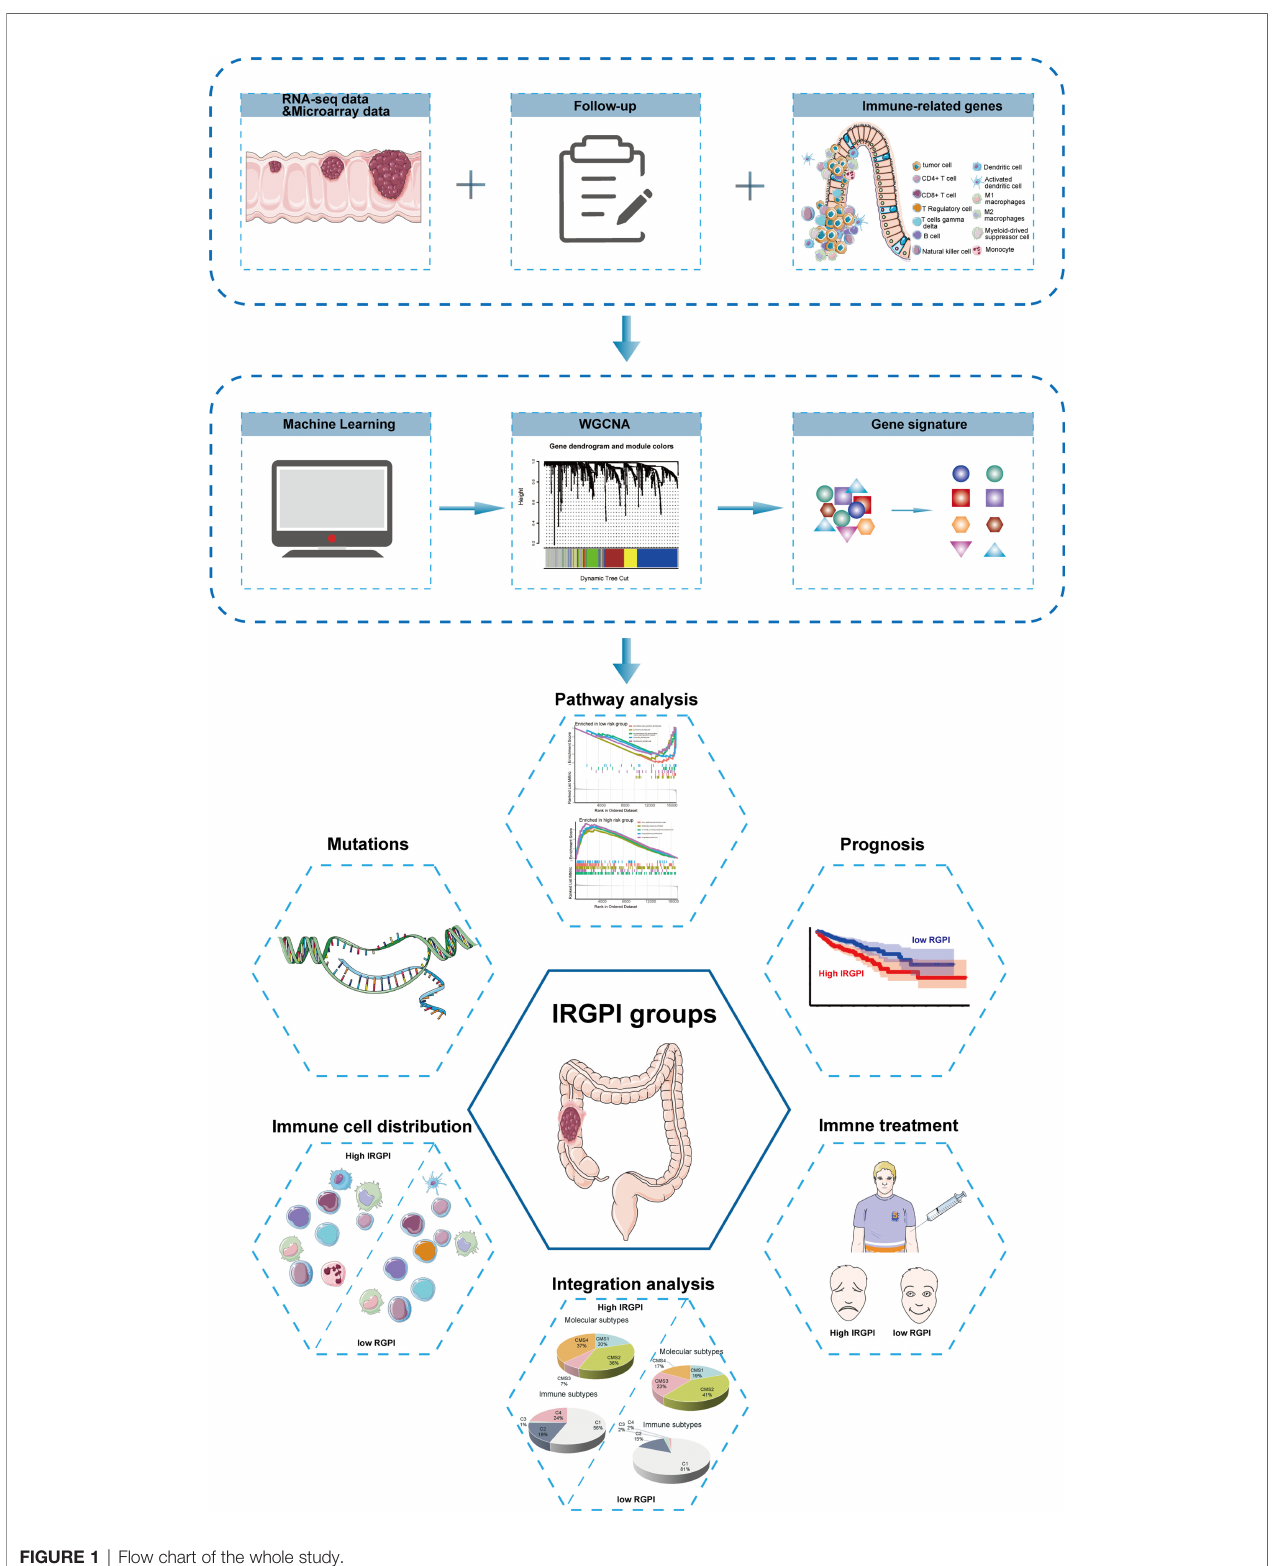
FIGURE 1 | Flow chart of the whole